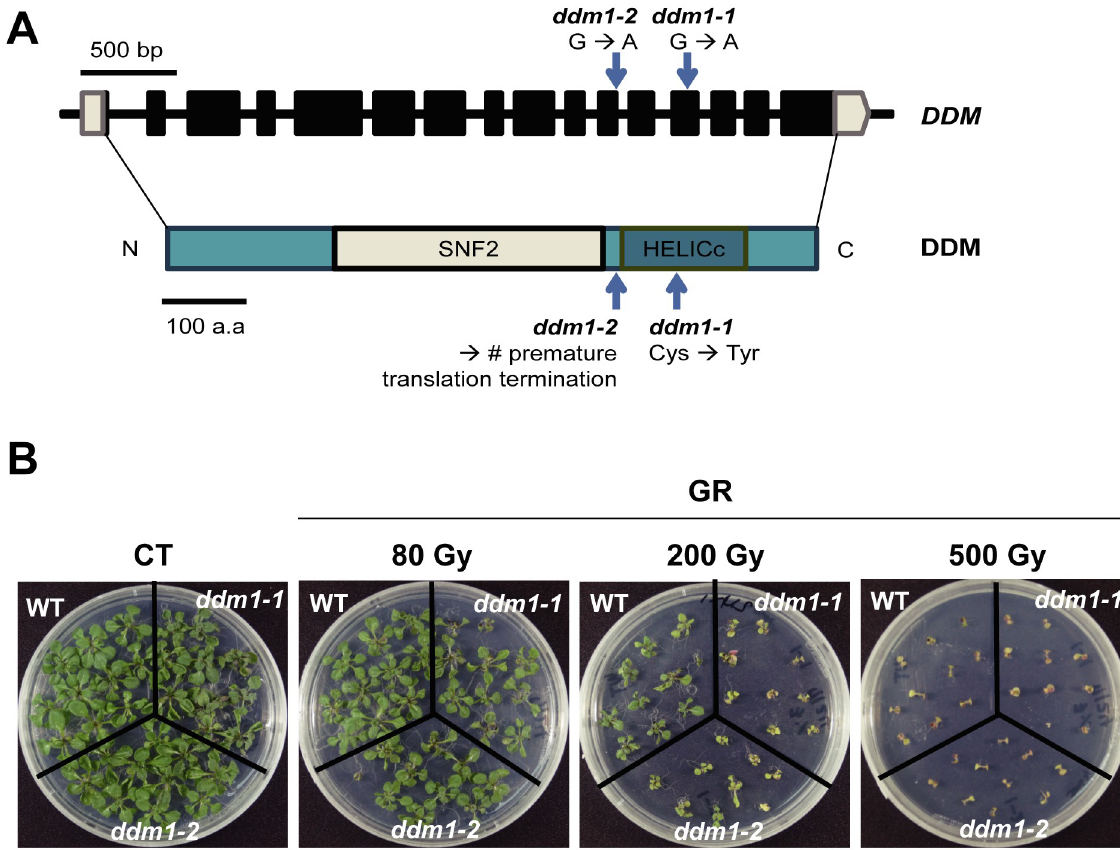
Fig 1. ddm1 mutants show hypersensitive phenotypes after gamma irradiation. (A) Physical map of DDM1 and its mutations in ddm1 mutants. (B) Phenotypes of Col-0 (WT) and ddm1 mutants after exposure to gamma radiation. Images were taken 14 days after gamma irradiation. CT, control; GR, gamma radiation. Digits in parenthesis indicate a dose of gamma radiation.